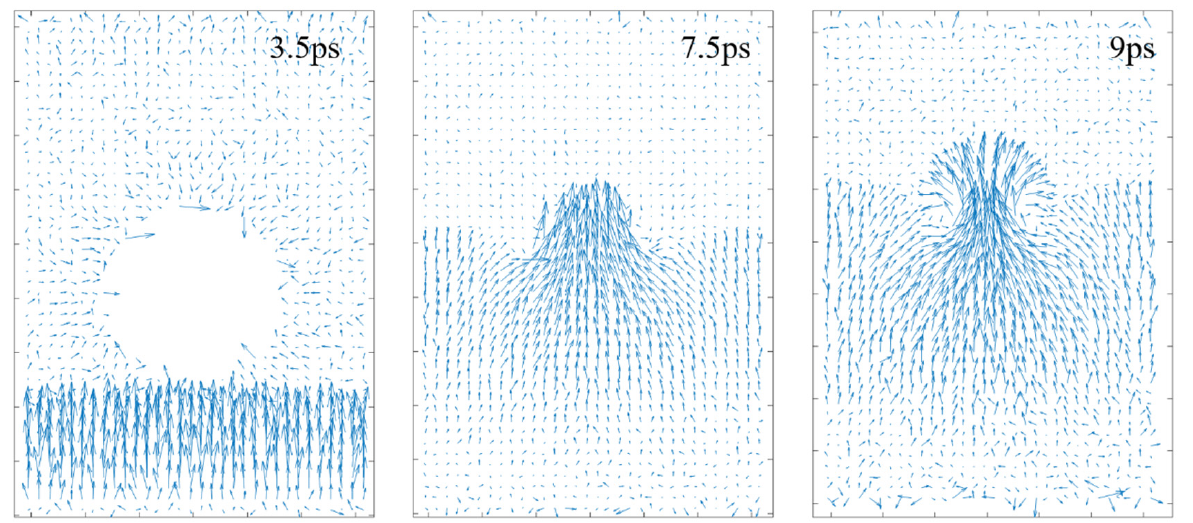
Figure 3. The distribution of liquid velocity at several simulation times, which correspond to, respectively, ( left ) the moment before the shock wave reaches the bubble, ( middle ) the jet forms, and ( right ) after the jet impacts the upper boundary of the bubble.